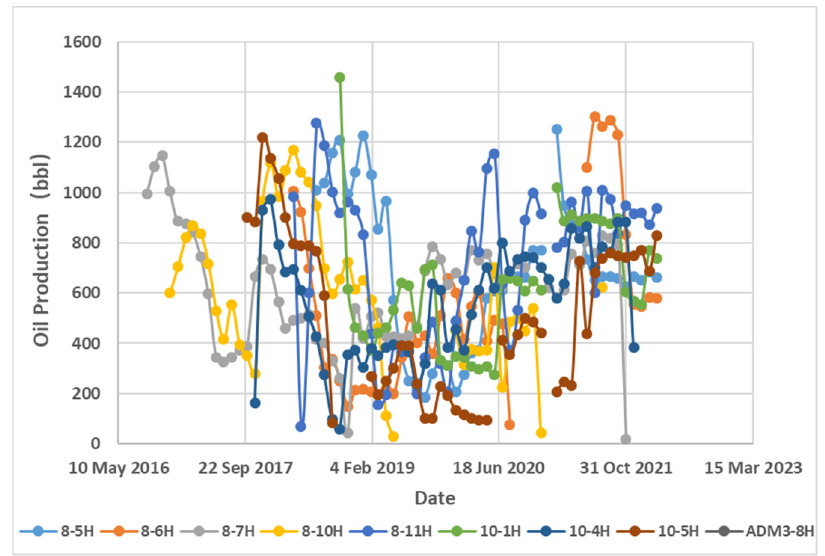
Figure 26. Oil production variation curve of injection ‐ production horizontal well pattern.